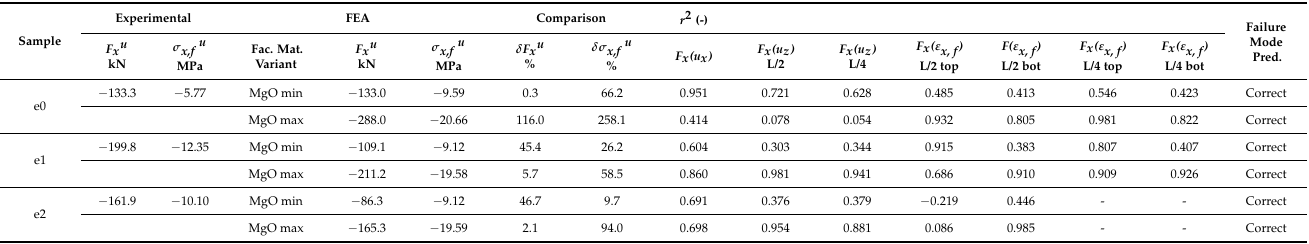
Table 4. Summary of full-scale test